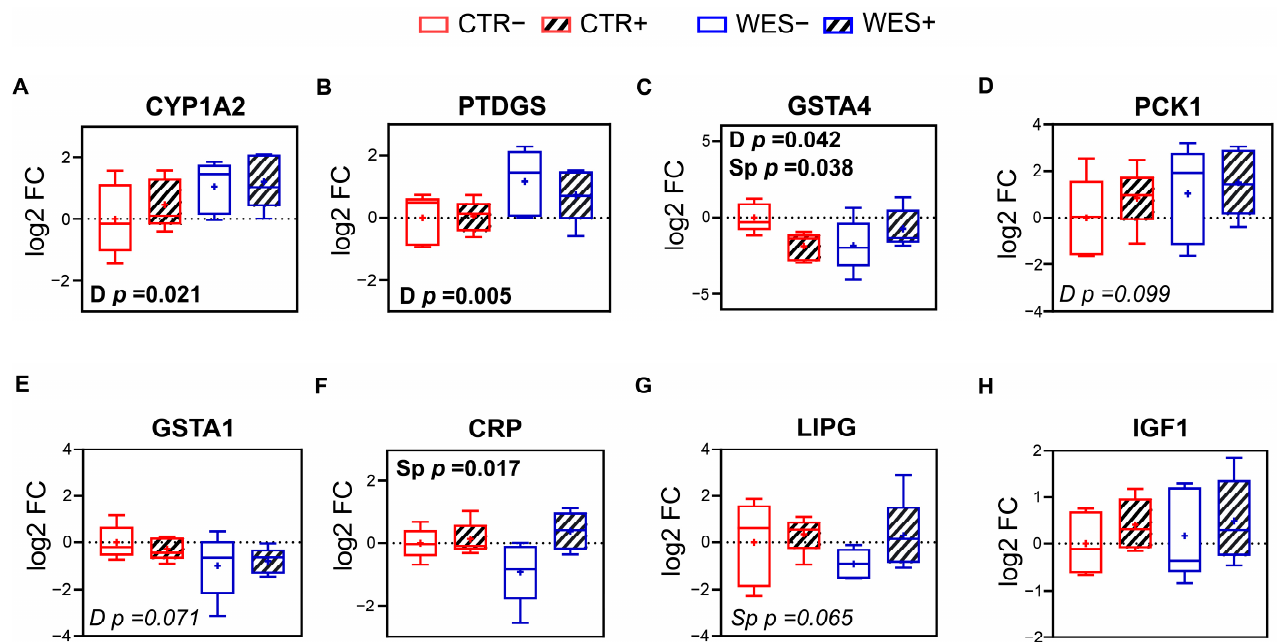
Figure 5. Validation of RNAseq results of selected differentially expressed genes in liver via qRT-PCR. Hepatic levels of expression of ( A ) cytochrome P450 family 1 subfamily A member 2 ( CYP1A2 ), ( B ) prostaglandin D2 synthase ( PTDGS ), ( C ) glutathione S-transferase alpha 4 ( GSTA4 ), ( D ) phosphoenolpyruvate carboxykinase 1 ( PCK1 ), ( E ) glutathione S-transferase alpha 1 ( GSTA1 ), ( F ) C-reactive protein ( CRP ), ( G ) lipase G ( LIPG ), and ( H ) insulin-like growth factor 1 ( IGF1 ). CTR: control diet; WES: Western diet; D: diet; Sp: spirulina. Data are presented in boxplots with Spear style whiskers (min to max).